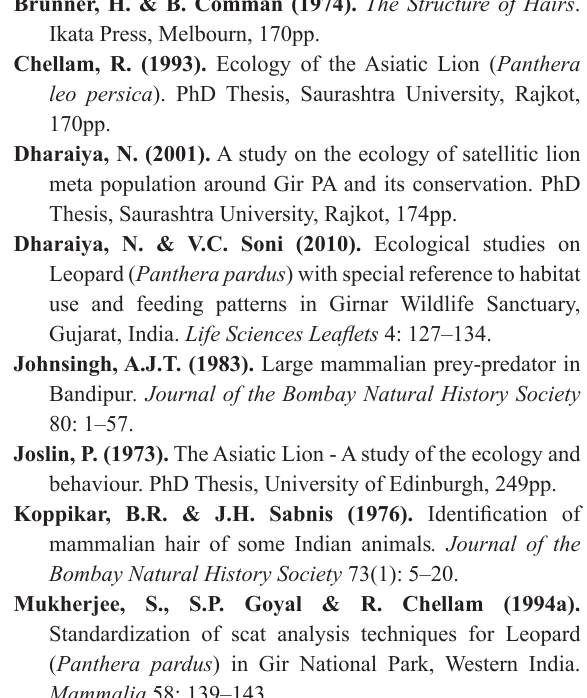
Macroscopic appearance of the hair Colour Length (cm) Diameter (m)Proximal Distal White